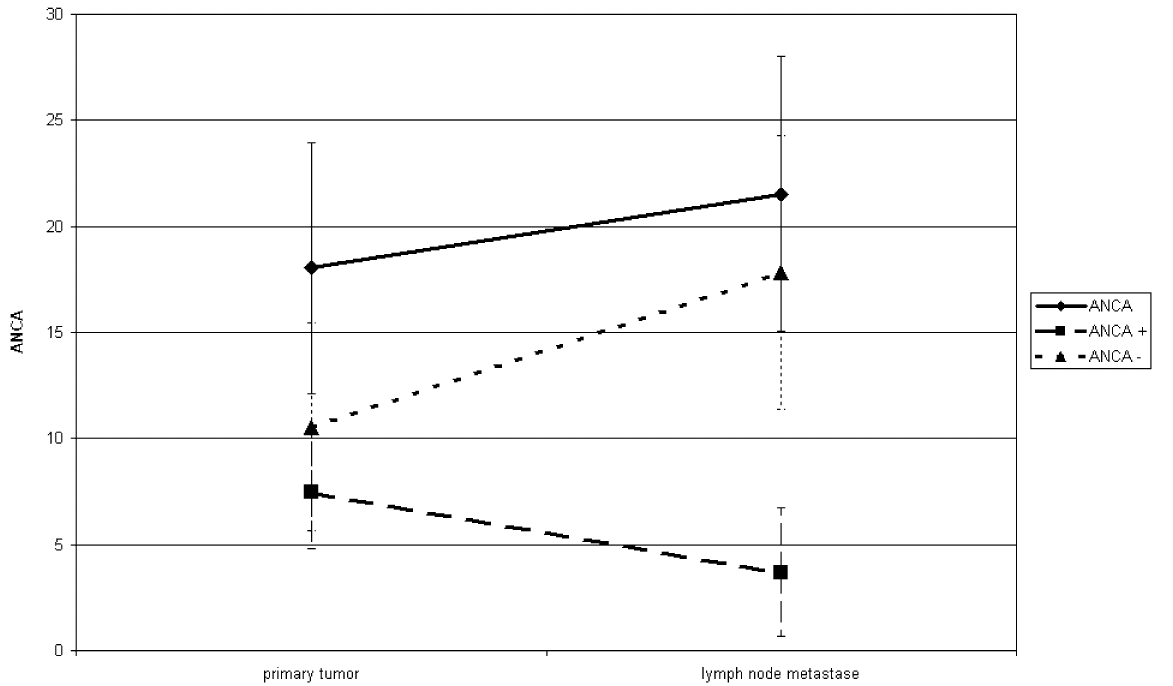
Fig. 4. Averaged number of copy alterations (ANCA) for the comparison of primary tumors and their corresponding lymph node metastases. The vertical lines represent the standard